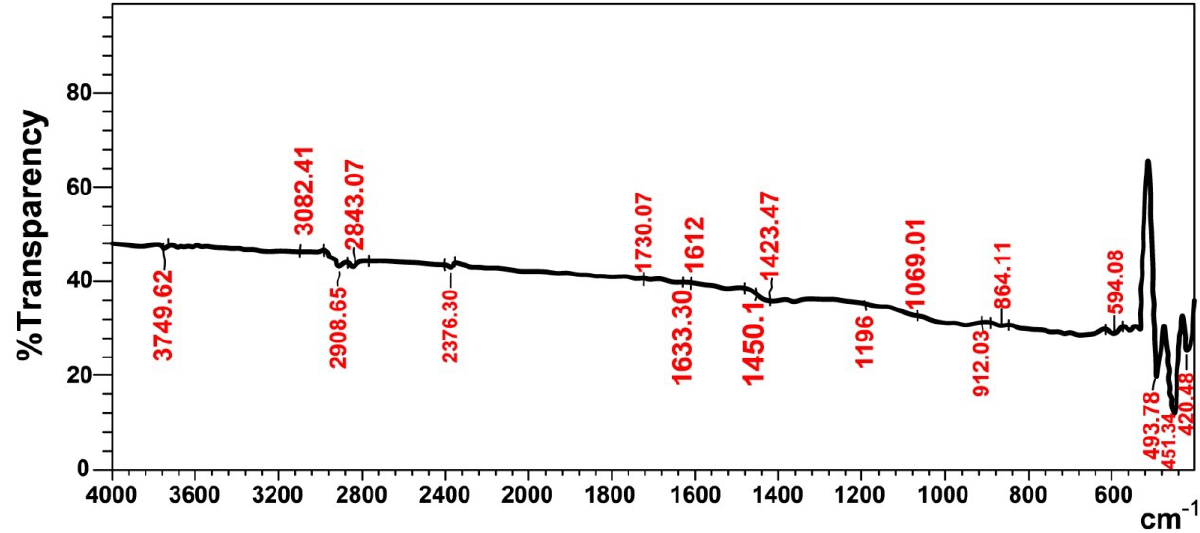
Figure 1. FTIR spectra of original scrap tire rubber before treatment.